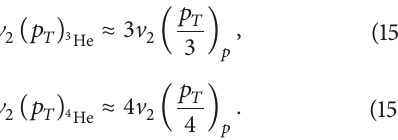
lines) from the PHENIX and ALICE experiment is shown